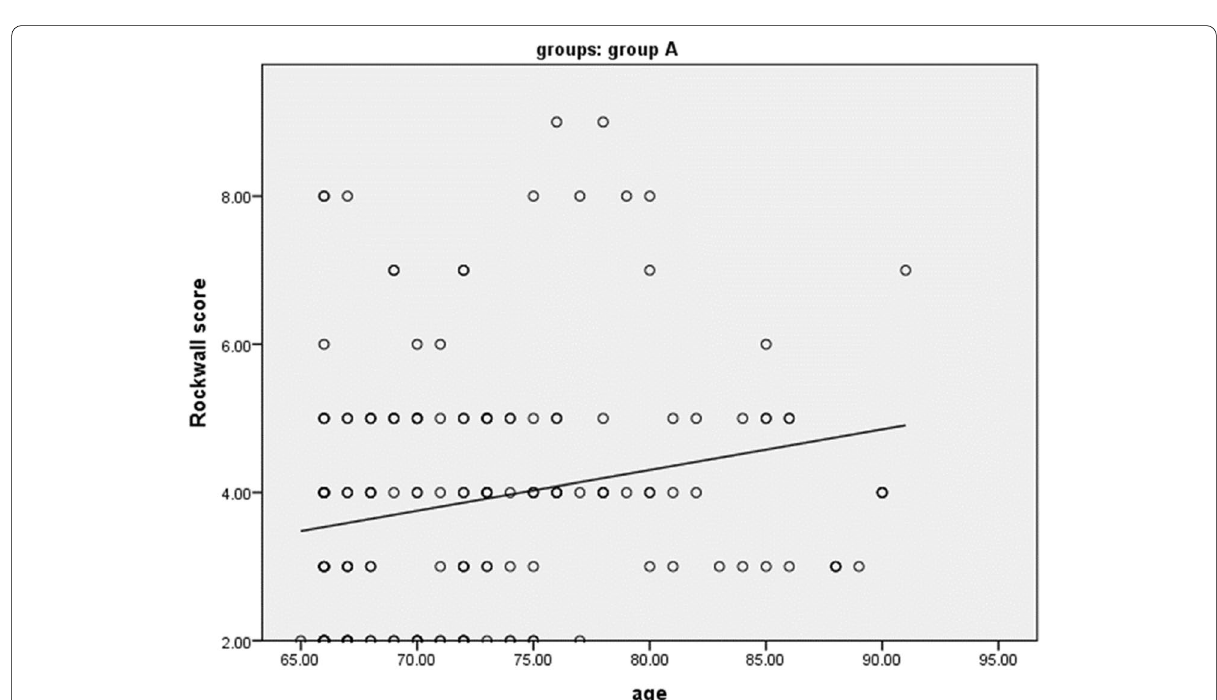
Fig. 1 Comparing Rockall score between both